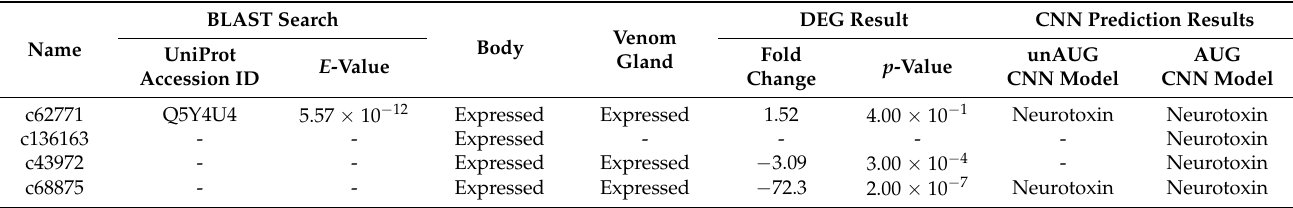
Table 3. Selected neurotoxic peptides predicted with neuromodulatory effects.